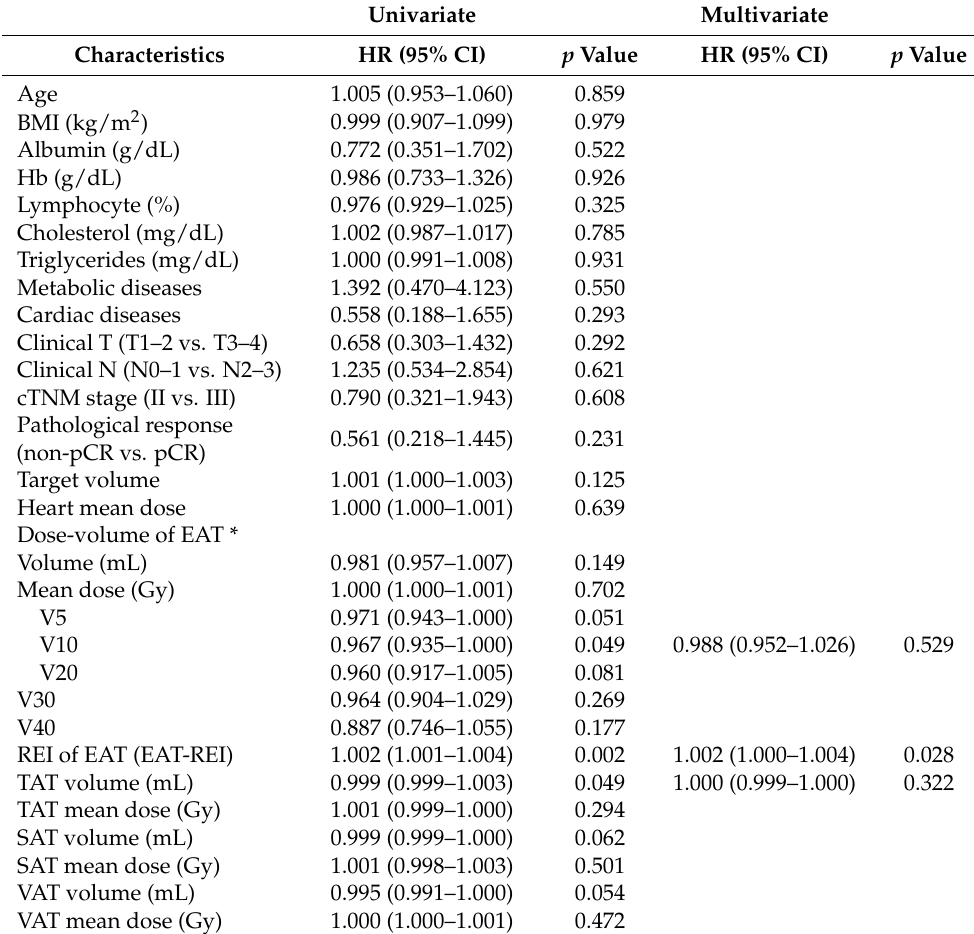
Table 2. Univariate and multivariate Cox proportional hazards model for overall survival. Univariate Multivariate